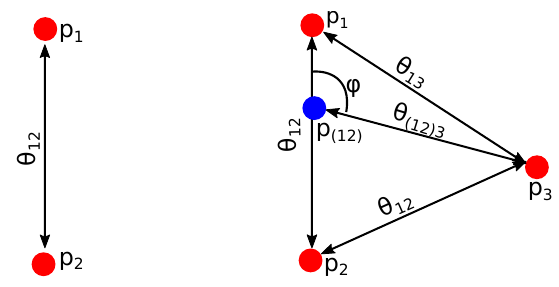
Figure 15 . Con(cid:12)gurations with maximal mass for LO (left) and NLO (right). p = (1 (cid:0) x ) p , respectively, the jet mass is given t 2 t